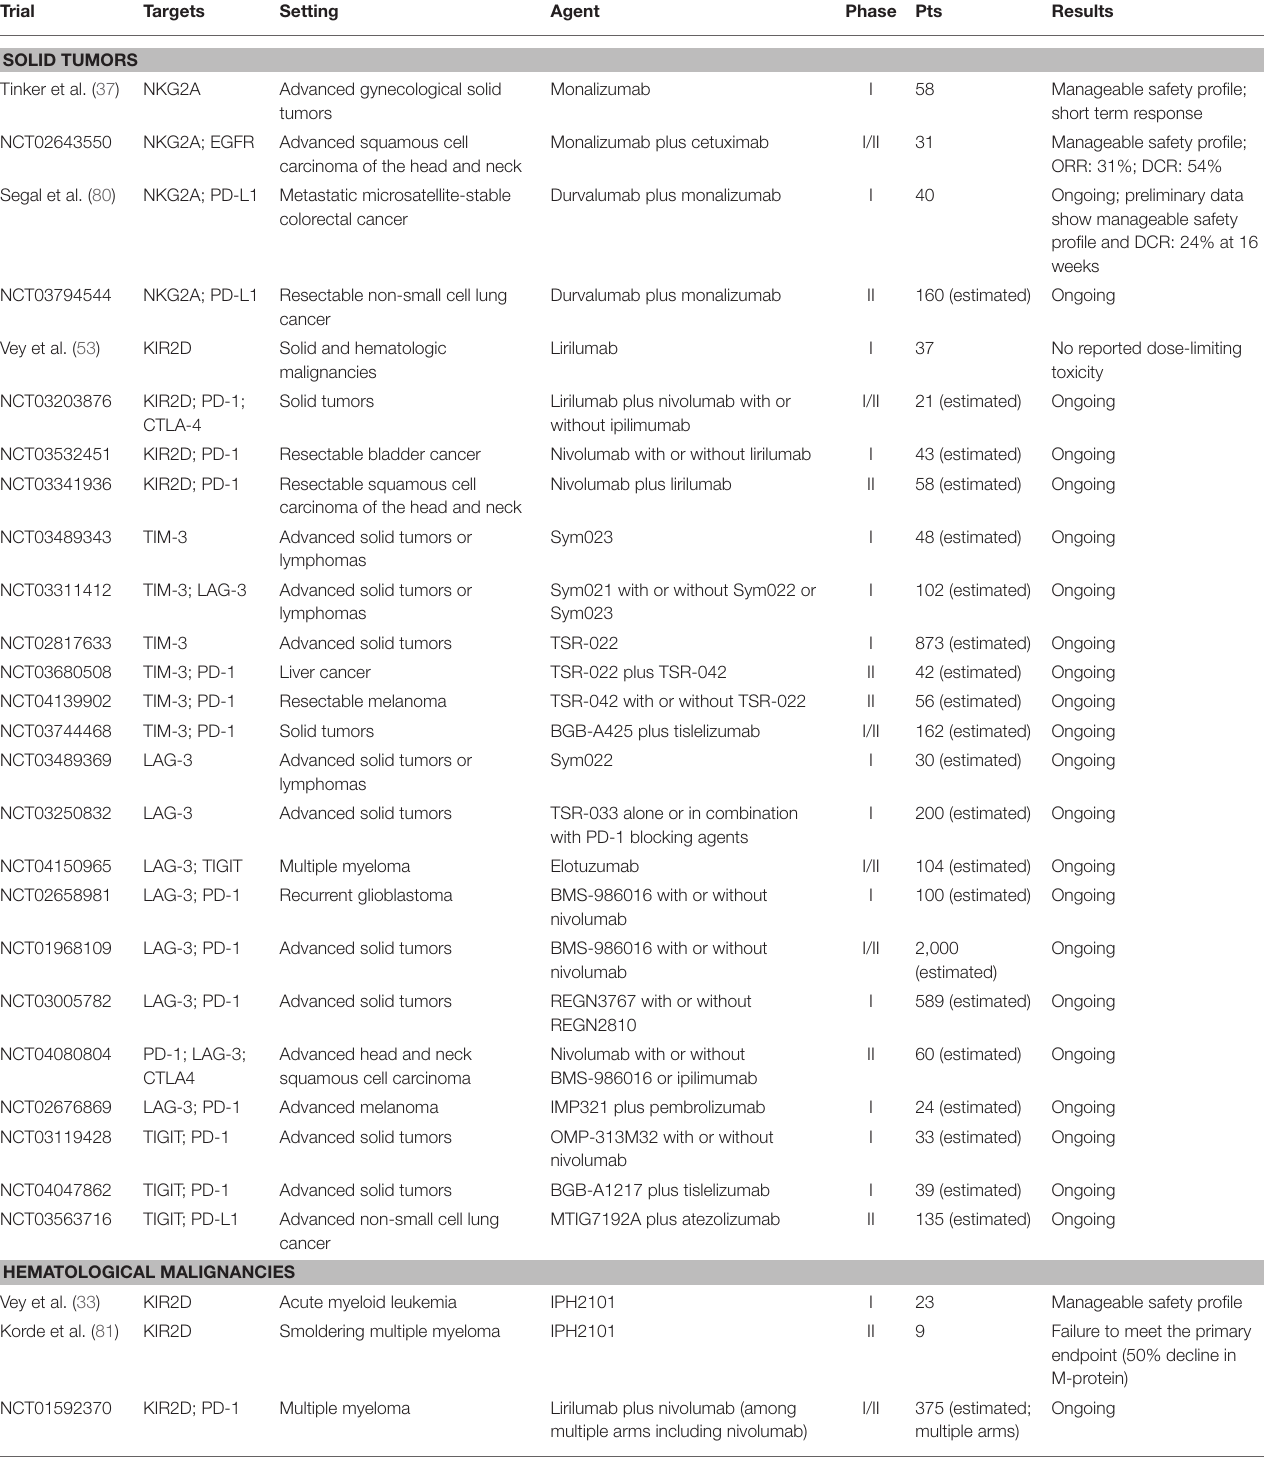
TABLE 1 | Relevant clinical trials involving immune checkpoint blockade in NK cells.